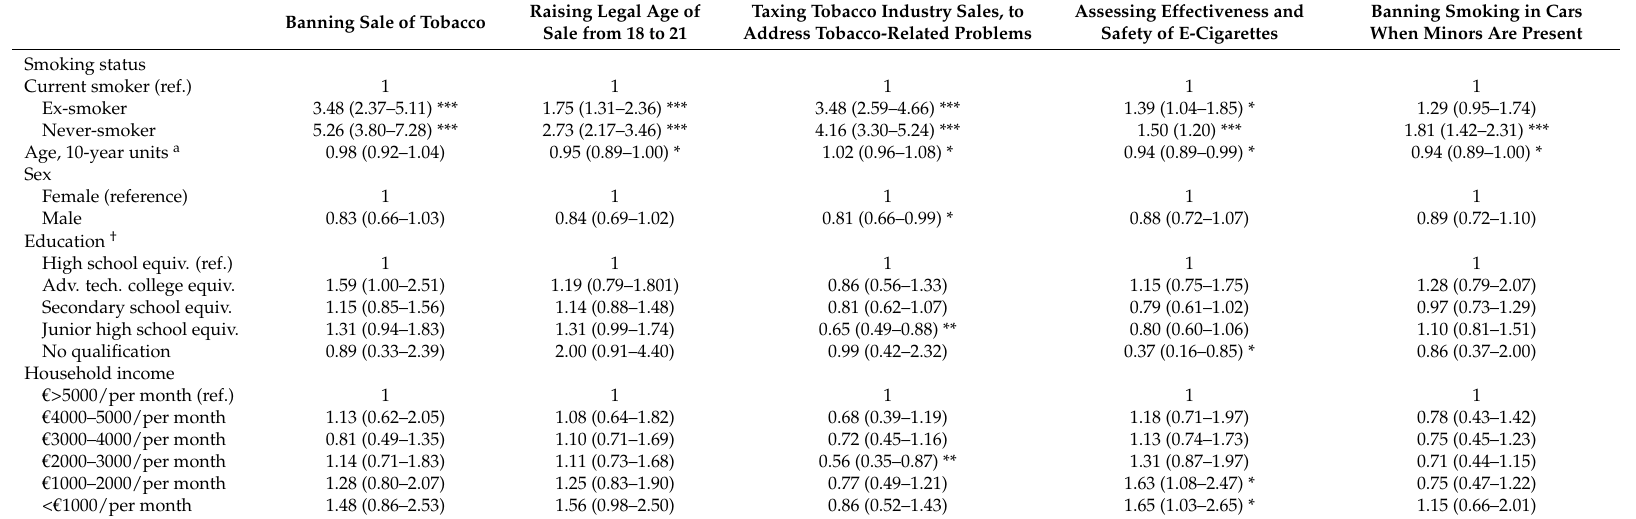
Table 3. Multivariate associations with support (agree/totally agree) for the policy statements in the total sample ( n = 2062).